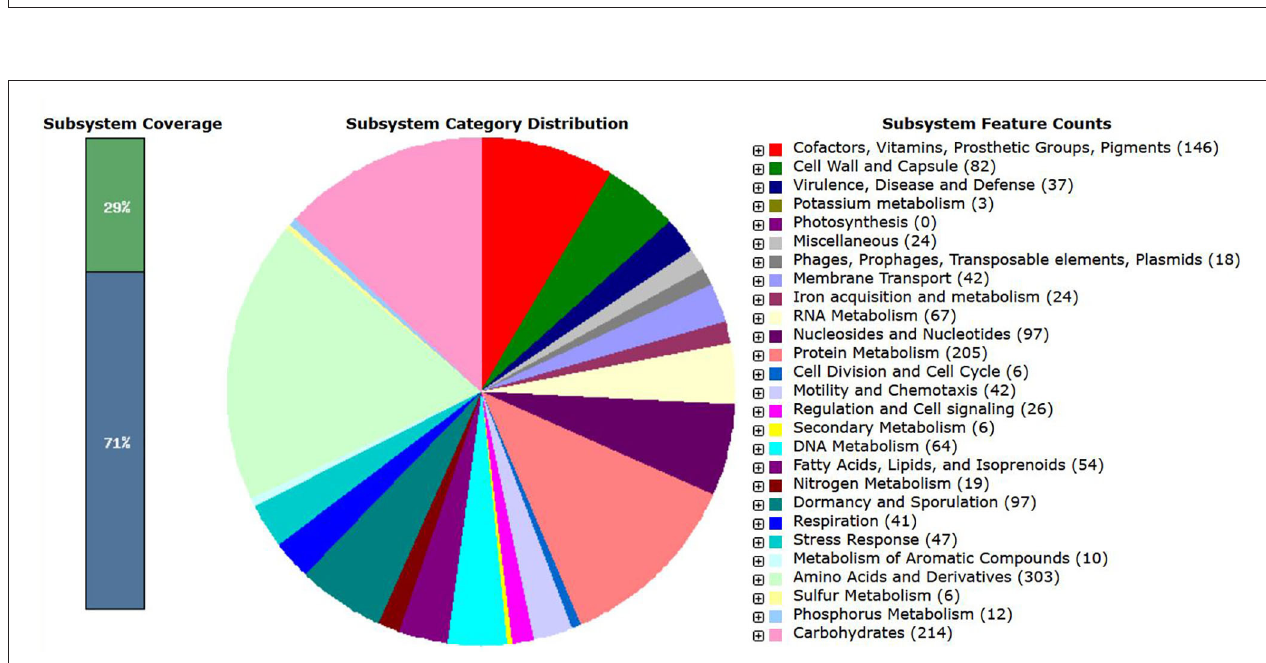
FIGURE 2 | Schematic overview of subsystem coverage, distribution of subsystem category, and subsystem feature counts anticipated in Bacillus amyloliquefaciens strain CB using RAST server.